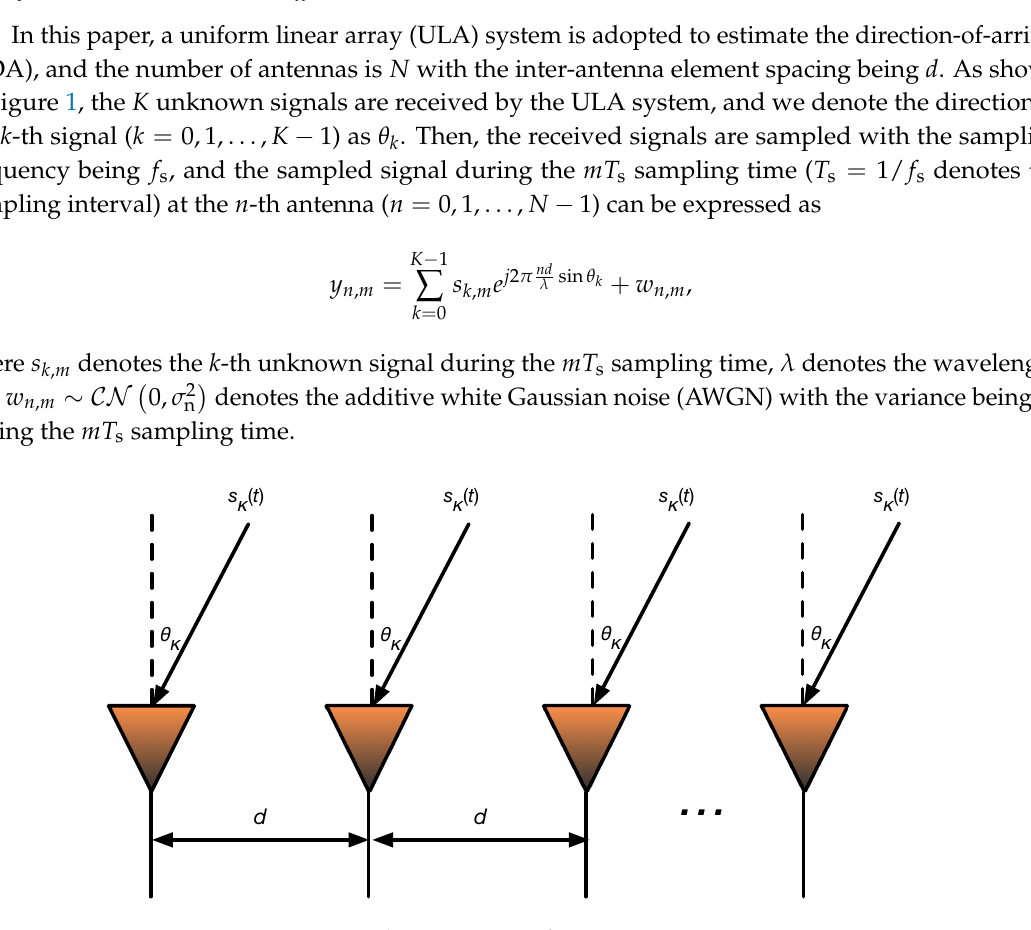
Figure 1. The ULA system for DOA